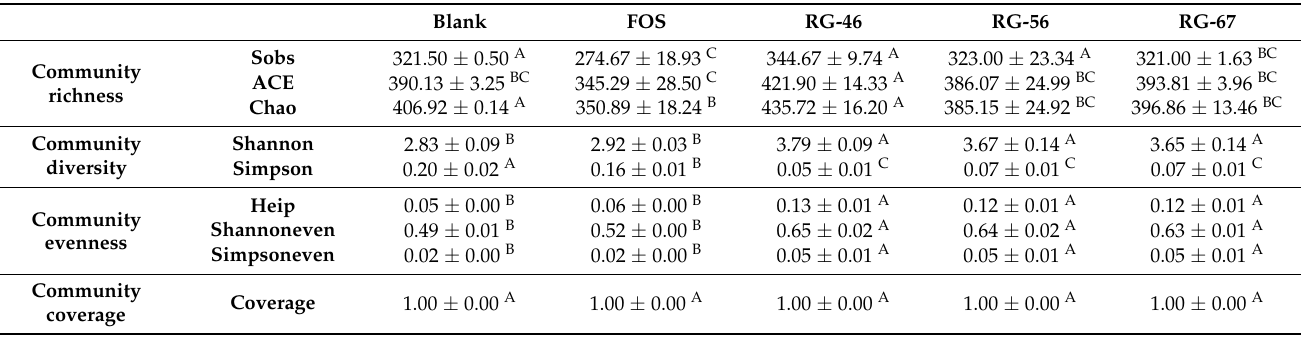
Table 2. Analysis of alpha diversity in gut